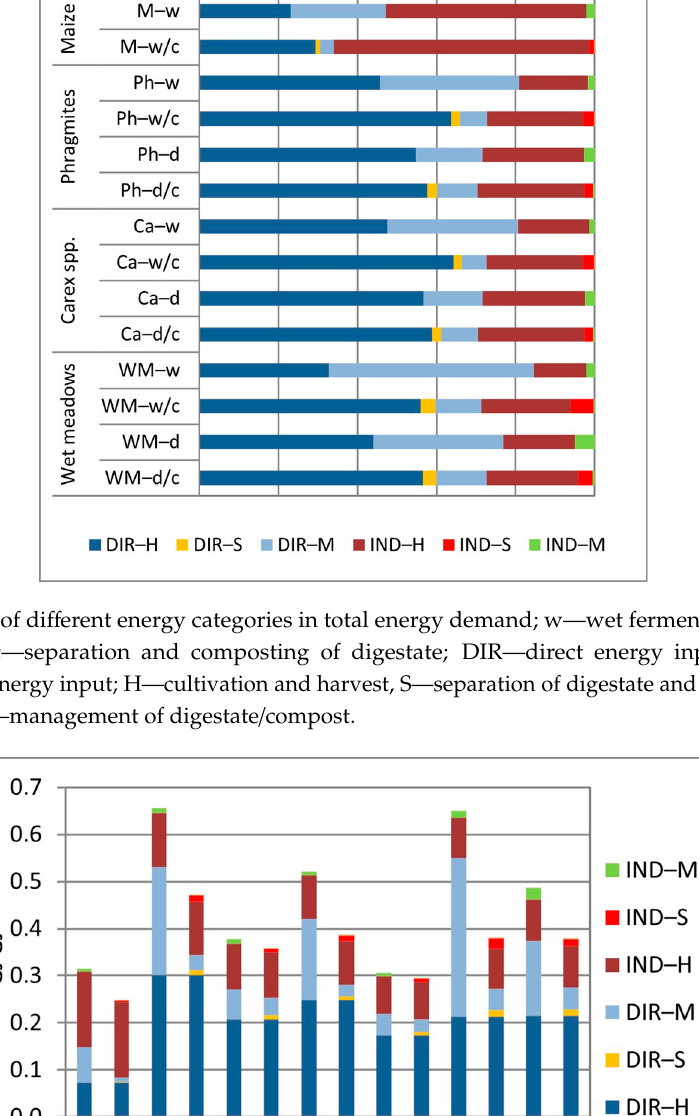
Figure 4. Energy consumption calculated for all steps of energy production from biomass; w—wet fermentation, d—dry fermentation, c—separation and composting of digestate; DIR—direct energy input from fuel, IND—indirect energy input; H—cultivation and harvest, S—separation of digestate and composting of solid phase, M—management of digestate/compost.